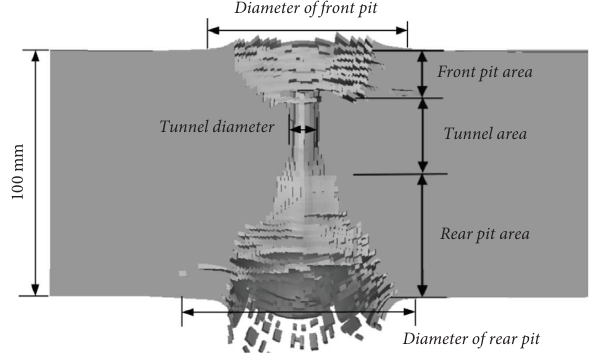
Figure 8: Damage zone when fragments penetrate the concrete. Figure